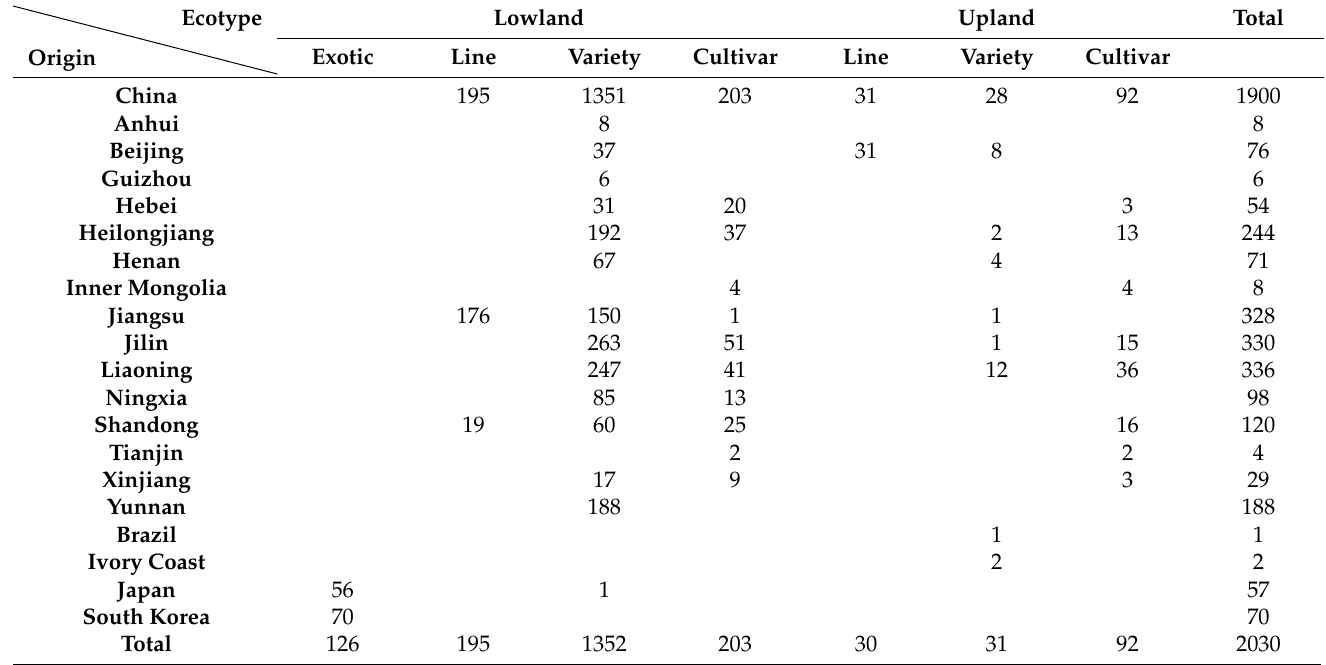
Table 1. Origin, ecotype and type of germplasm evaluated in the